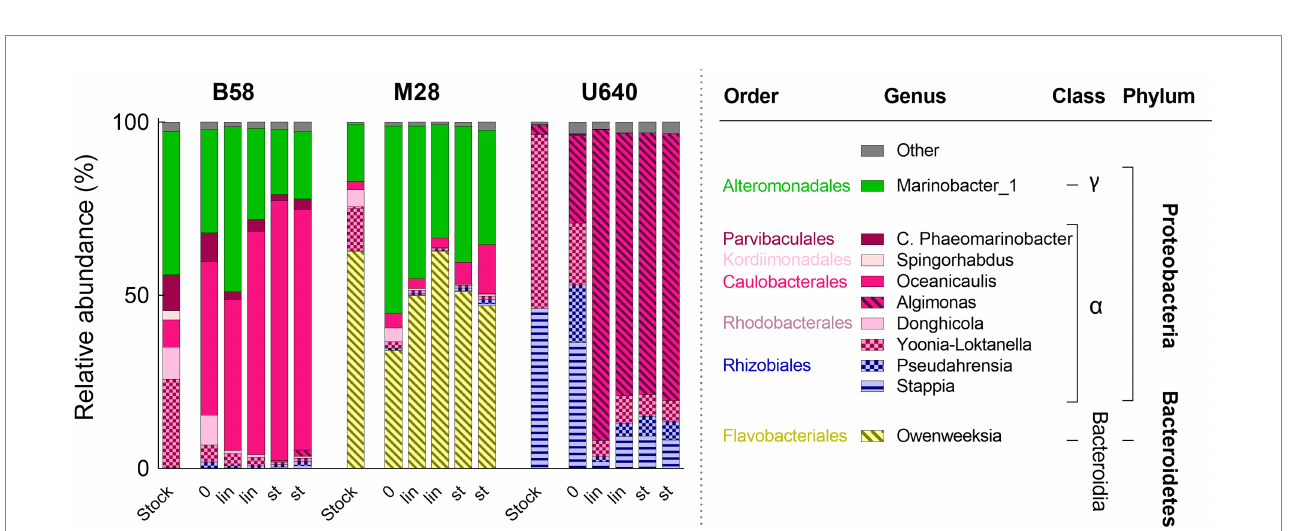
FIGURE 7 Bacterial community composition during batch cultivation in bubble columns of three Phaeodactylum strains in NORCE medium with two biological replicates each. Bacterial genera with an abundance of higher than 5% are shown, bacteria with lower abundance are summarized in “Other.” 0: start of the cultivation, lin: linear growth phase, st: stationary phase. For each strain, the bacterial community composition of the respective NORCE stock culture is shown from Figure